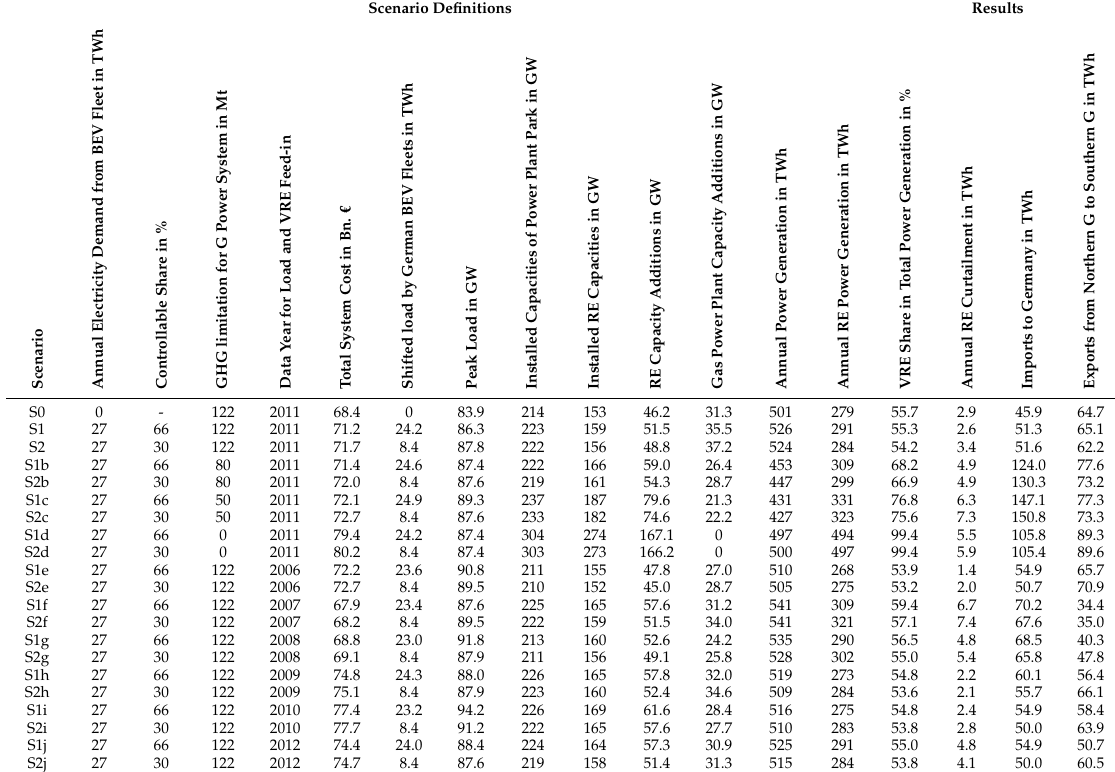
Table A8. Overview on scenario definitions and main annual results of the sensitivity analysis on the CO 2 emission limit and historic weather year used. Total system costs are given for the complete system boundary while all other values are given for